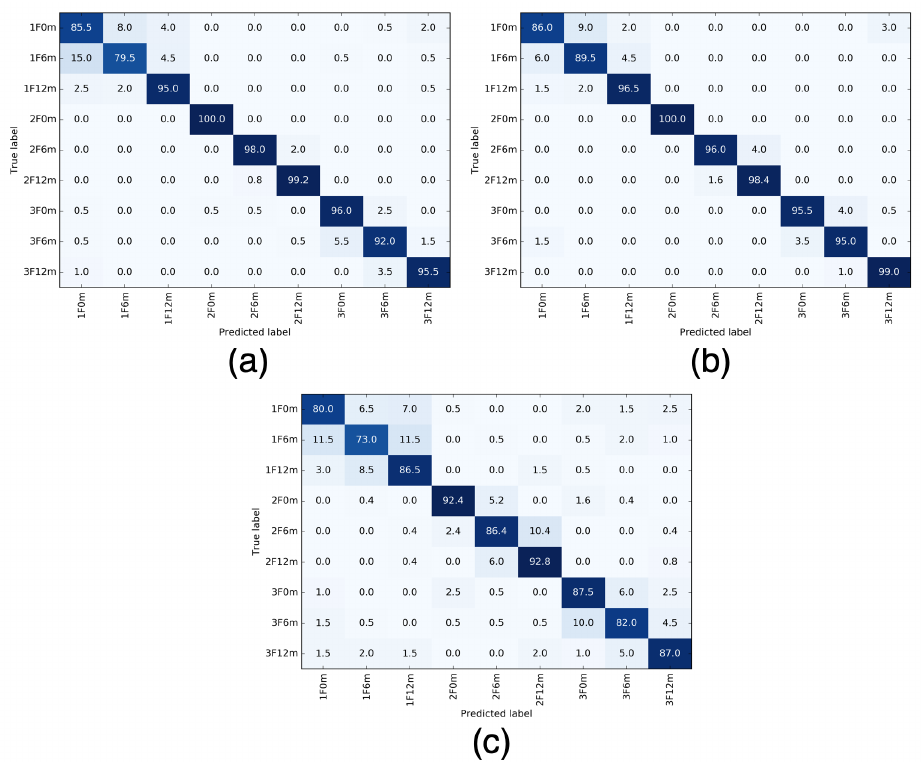
Figure 5. Confusion matrices of the position classification results (%). ( a ) AlexNet, ( b ) VGG16, and ( c ) ResNet V1